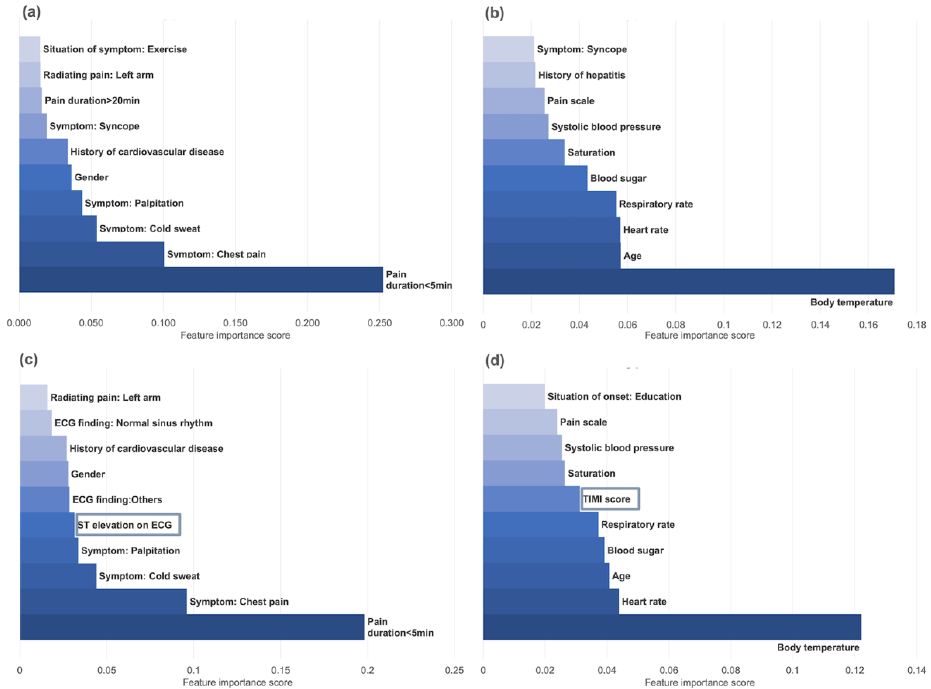
Figure 5. Feature importance score of XGB derived A- ( a ) and B- ( c ) type models compared to MLP- derived A- ( b ) and B- ( d ) type models (XGB: Extreme gradient boosting; MLP: Multilayer